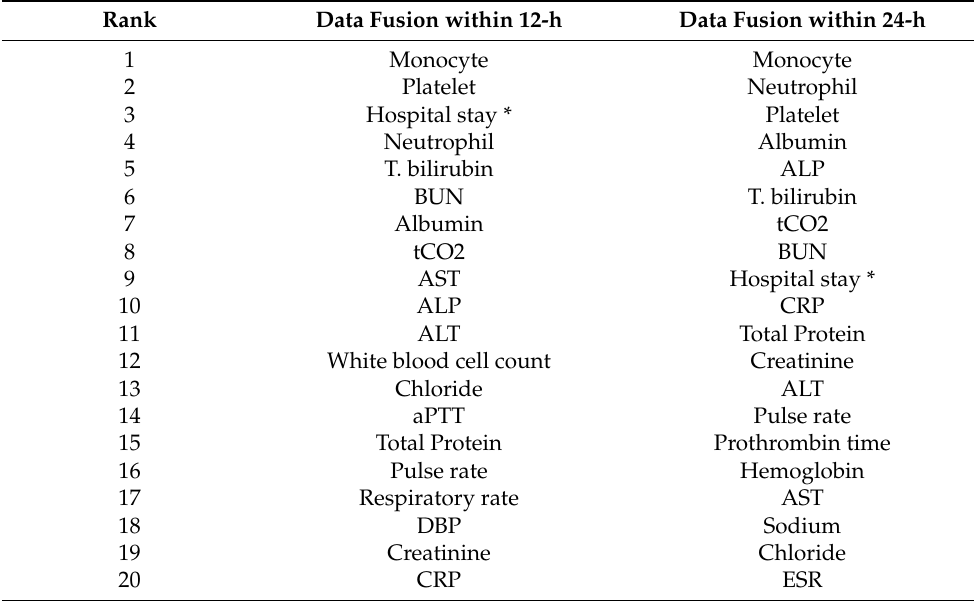
Table 2. Influence ranking of clinical variables to bacteremia